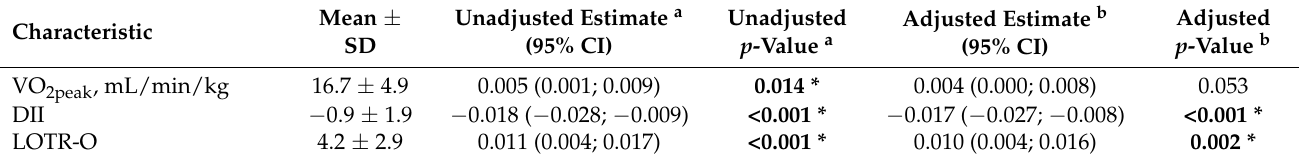
Table 3. Associations between MEDAS and metabolic, lifestyle, and HRQoL factors using linear regression models.